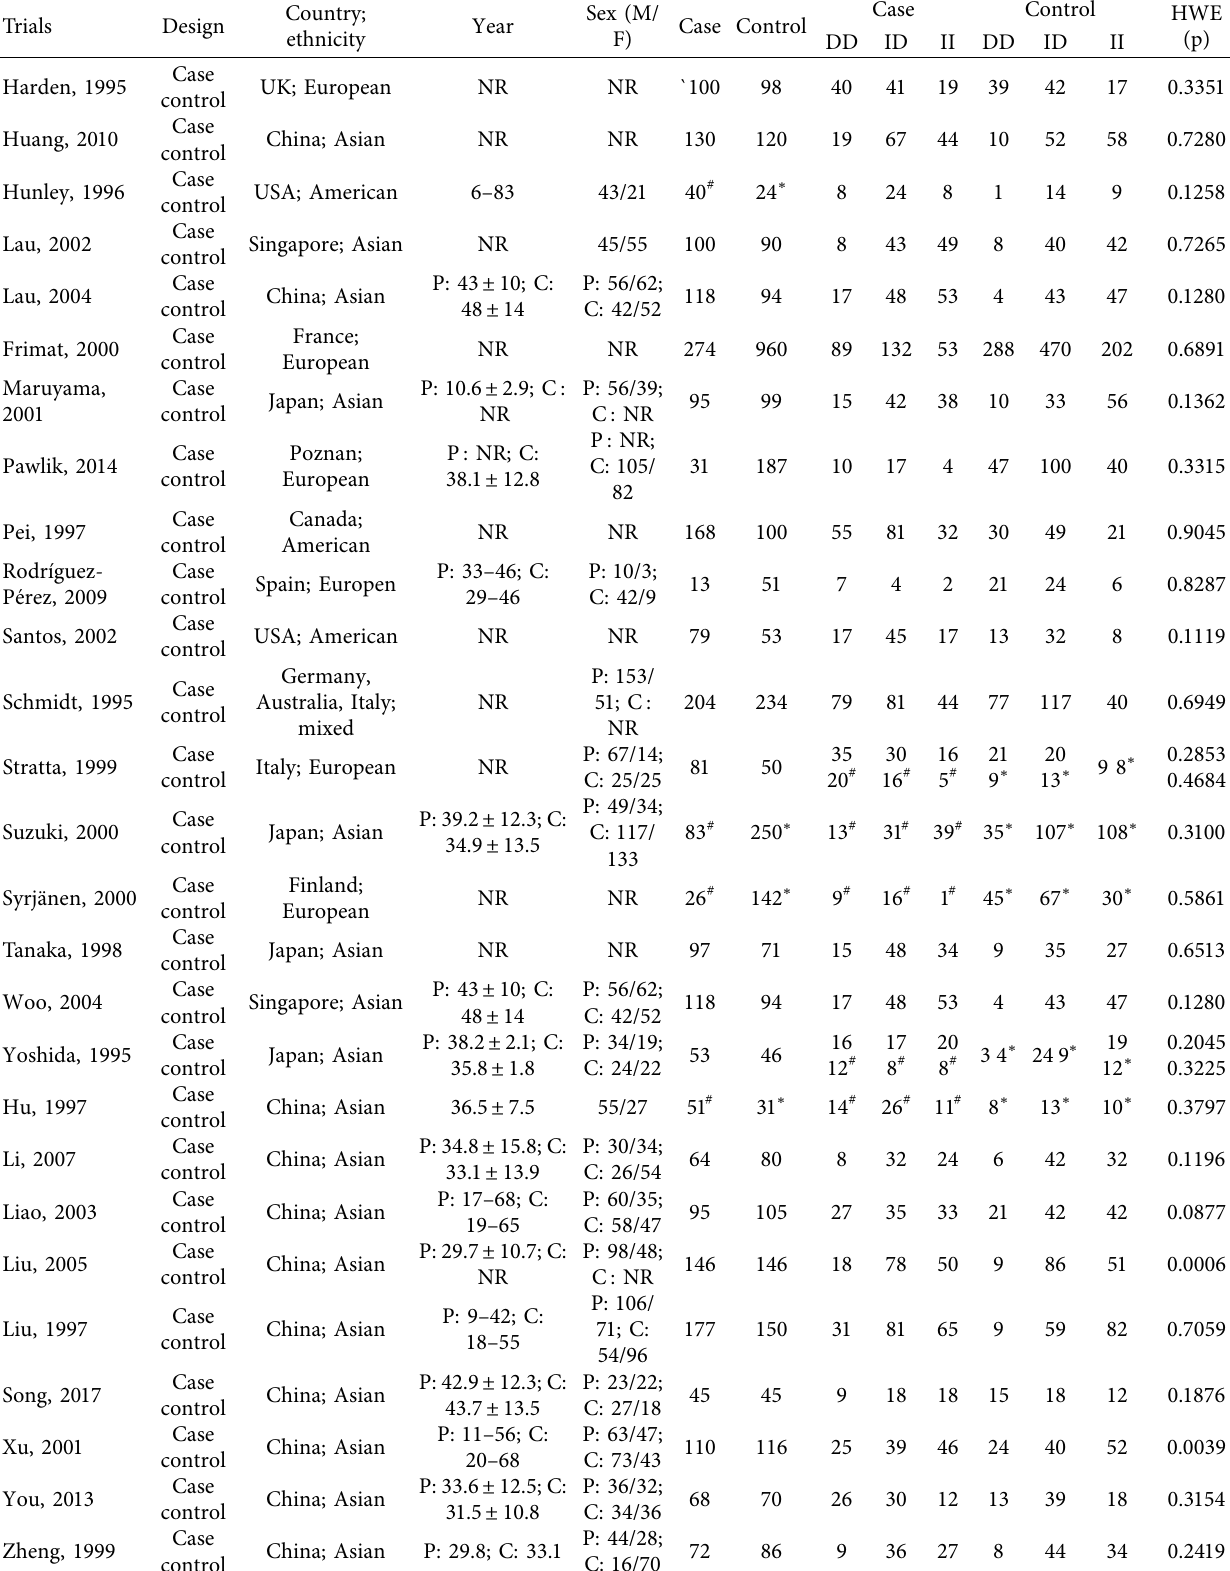
Table 1: Characteristics of studies included in the